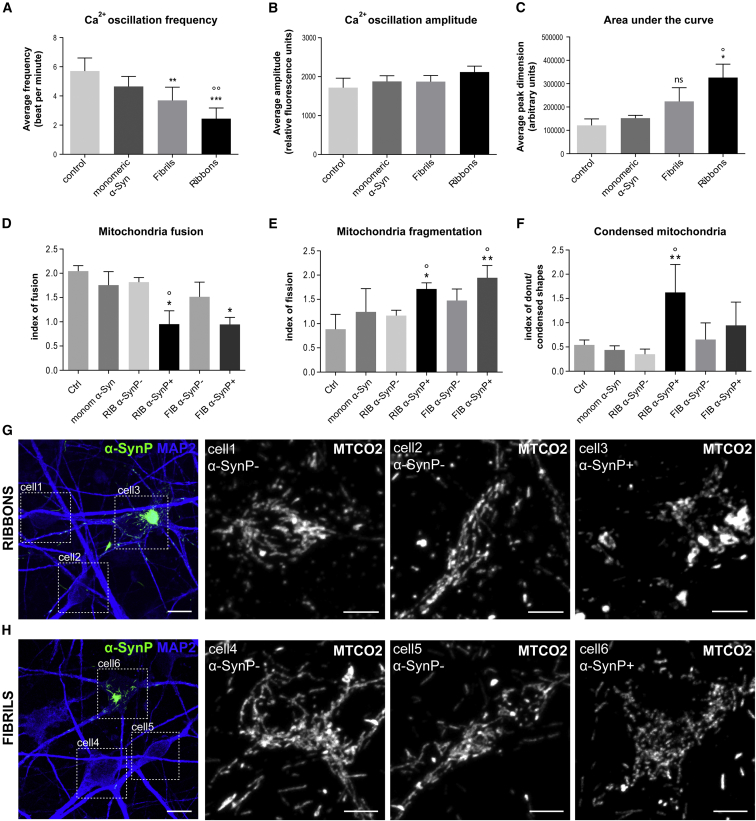
Alteration in Ca2+ Homeostasis and Morphological Impairment of Mitochondrial Networks in Human Neurons Following Exposure to α-Syn Strains and α-SynP Accumulation(A–F) (A–C) Whole-well Ca2+ imaging analyses on mature human cortical neurons 19 dpe to fibrils, ribbons, monomeric α-Syn, and untreated neurons. The (A) average frequency, (B) average amplitude, and (C) average area under the curve of the Ca2+ waves were analyzed for each well. Asterisks indicate significant difference of α-Syn strain-treated neurons versus control; circles indicate significant difference of α-Syn strain-treated neurons versus monomeric α-Syn. (D–F) Analysis of the index of (D) fusion, (E) fragmentation, and (F) donut-shaped/condensed mitochondria in untreated neurons or neurons at 21 dpe to monomeric α-Syn, ribbons, or fibrils. Asterisks indicate significant differences of treated neurons versus control; circles indicate significant differences of α-SynP+ versus α-SynP− cells in the same culture. ∗ and °p < 0.05, ∗∗ and °°p < 0.01, ∗∗∗p < 0.001. Data are shown as mean ± SEM, n = 3 (for statistical analysis see Supplemental Information).(G and H) Representative confocal images of neurons exposed to (G) ribbons and (H) fibrils. On the left the cells are stained for MAP2 (blue) and α-SynP (green). Highlighted cells (dotted lines) are enlarged and stained with MTCO2 (white). Cells 1, 2, 4, and 5 are α-SynP−. Cell 3 and cell 6 are α-SynP+. Scale bars: 10 μm in left image of (G) and (H); 5 μm in cell insets.